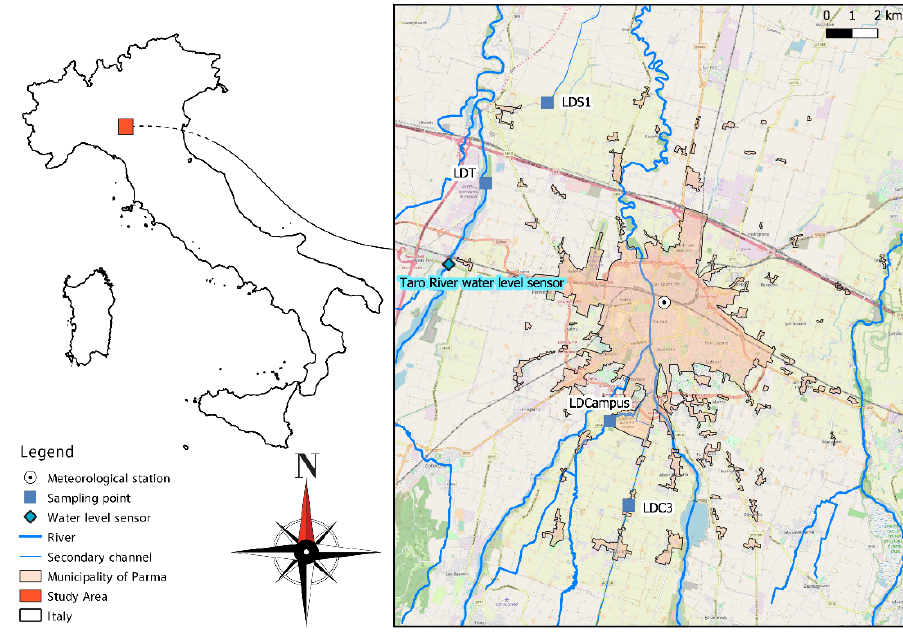
Figure 1. Study area. Base map and data from OpenStreetMap and OpenStreetMap Foundation